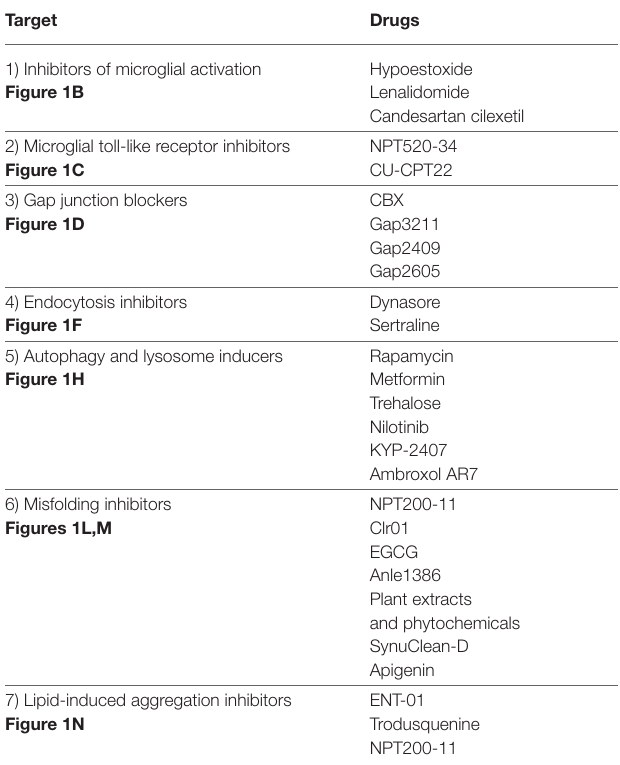
TABLE 1 | Therapeutic targets and drugs from Figure 1 .